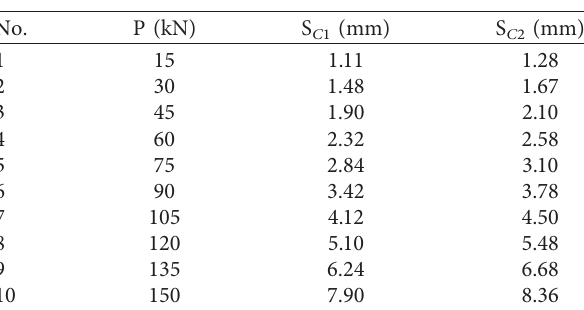
Table 11: Pullout test results from example 3.